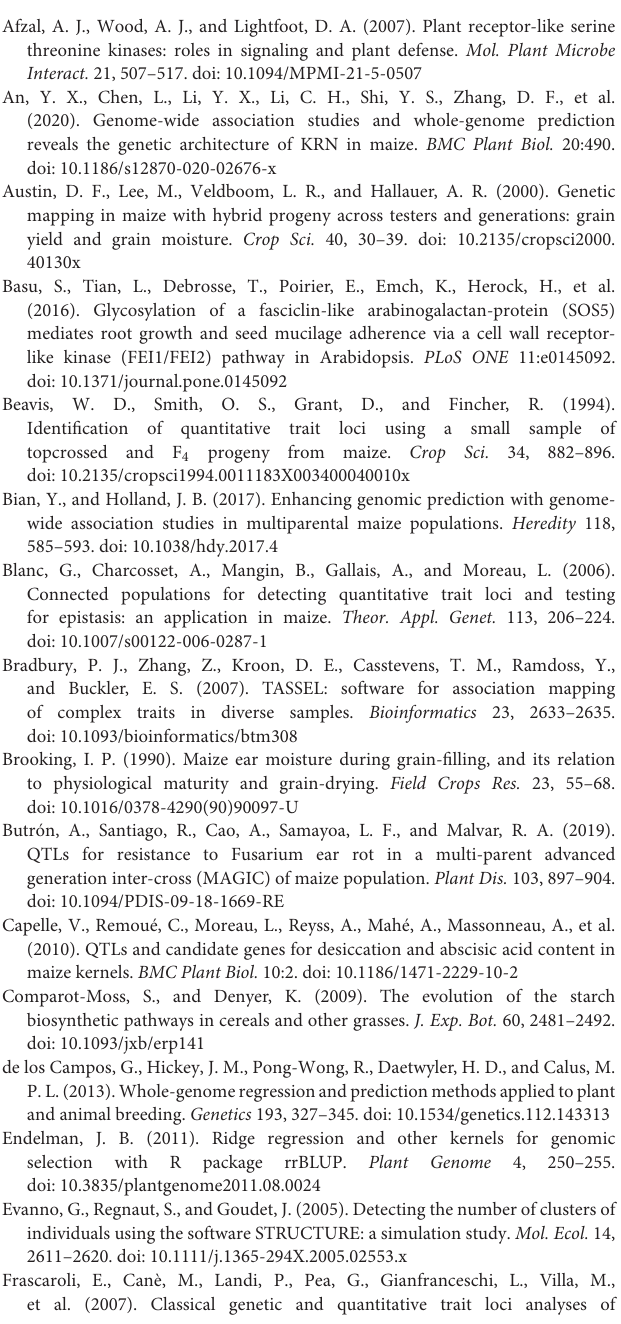
Supplementary Table 1 | The origin or pedigree, subpopulation, sowing data, and phenotype of 251 maize inbred lines used in this study. Supplementary Table 2 | Analysis of variance for KMC across three environments.